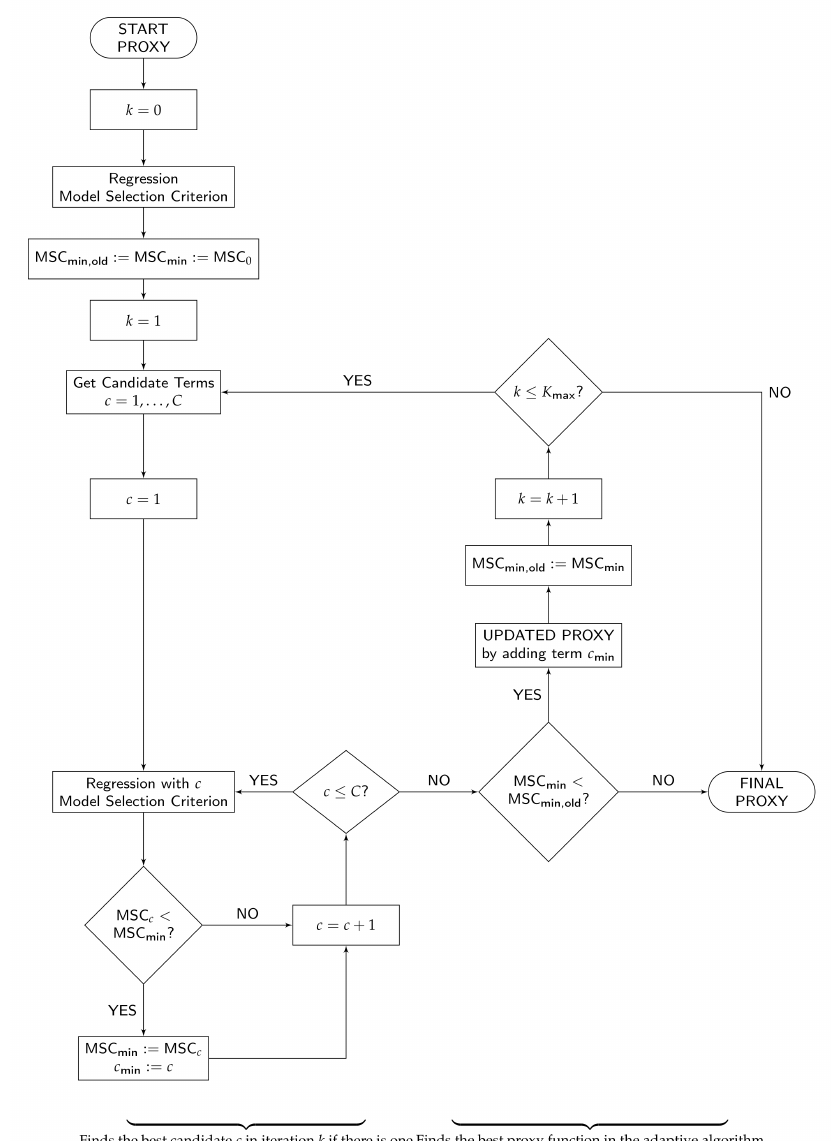
Figure 1. Flowchart of the calibration